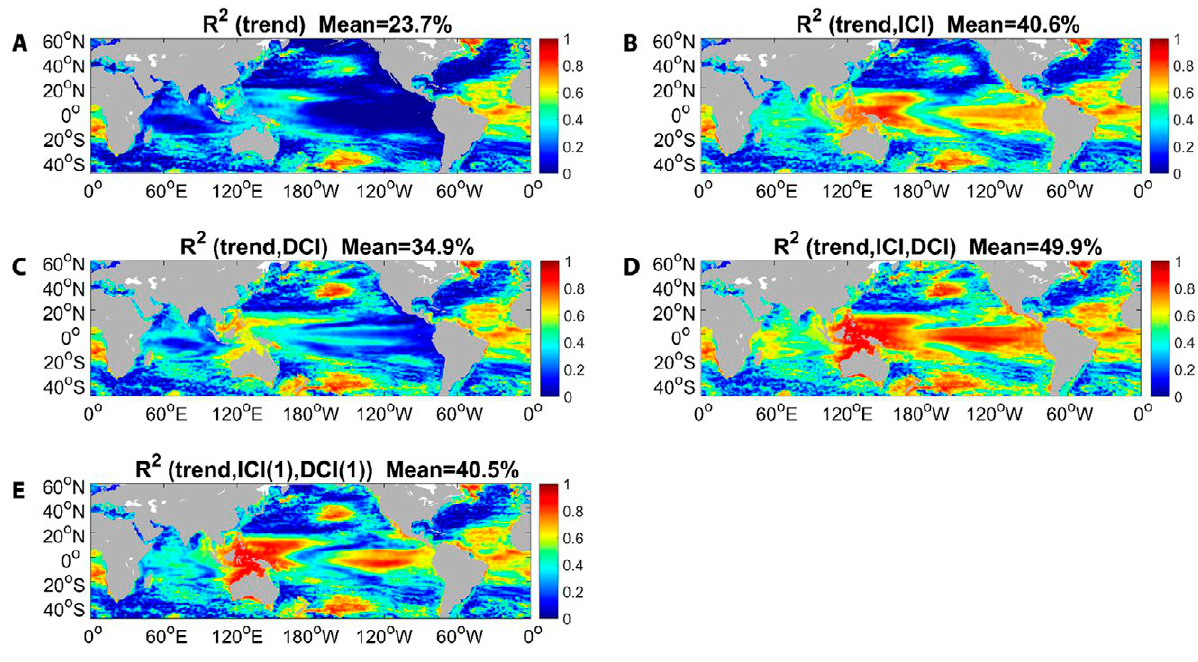
Fig. 4. – The coefficients of determination measuring the goodness of fit computed from the AVISO data for the period 1993-2012 using the following models: A, SVLR; B, MVLR without DCIs; C, MVLR with only trend and DCIs; D, MVLR with respect to trend along with all the dominant ICIs and